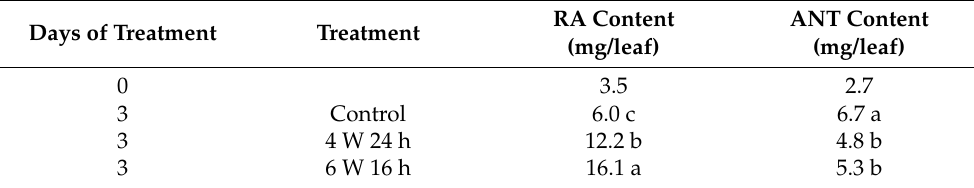
Table 4. Effect of UV irradiation on rosmarinic acid (RA) and anthocyanin (ANT) contents in the 4th leaf of red perilla after 3 d of UV-B treatment (experiment 2). The plants were exposed to UV-B irradiation at 0 W m − 2 (control), 4 W m − 2 at continuous irradiation (4 W 24 h), and 6 W m − 2 for a 16 h light period (6 W 16 h). RA Content Days of Treatment Treatment (mg/leaf)